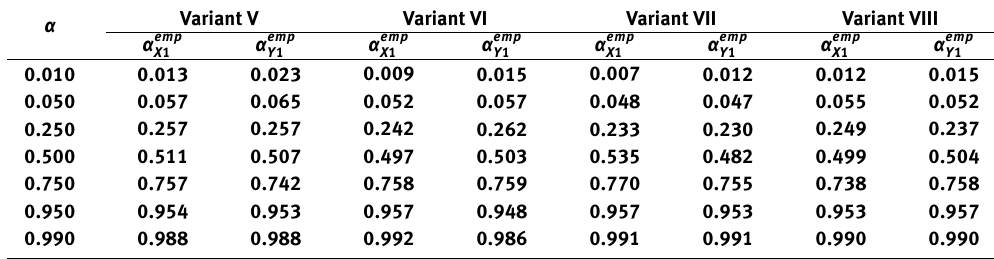
and α emp for HLWEs in horizontal X 1 Y 1